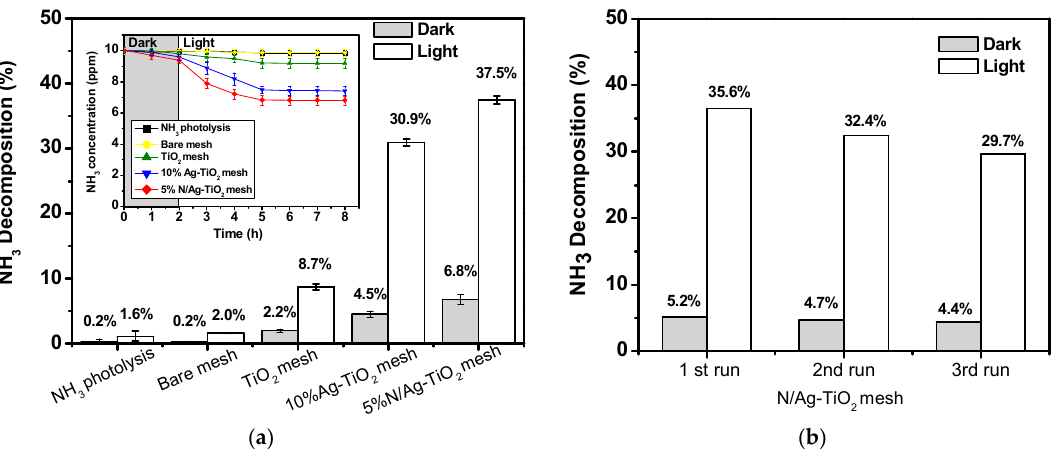
Figure 8. ( a ) Adsorption and photocatalytic performance for gas phase ammonia (NH 3 ) decomposition by different photocatalysts coated on stainless steel mesh under visible LED illumination for 3 h and ( b ) reusability performance of the 5% N/Ag-TiO 2 mesh.